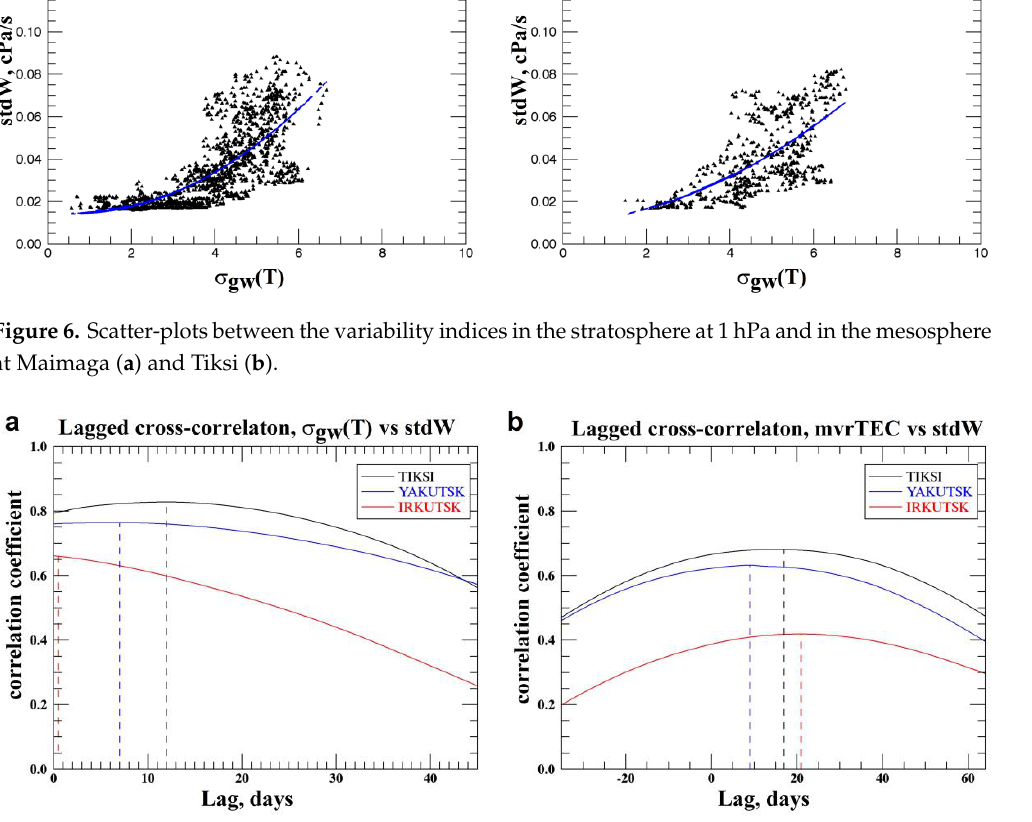
Figure 7. Lagged cross-correlation function between the variability indices in the stratosphere at 1 hPa and in the mesosphere ( a ), in the stratosphere and in the ionosphere ( b ) at Tiksi (black), Yakutsk (dark blue), and Irkutsk (red). Vertical dashed lines show the maxima of cross-correlation functions. For the ionosphere disturbance, the correlation levels at all the stations are lower. The